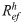
Estimation of Model TMAL in Period 1 (October/1995—September/2000).(a) observed incidence (O) and adjusted i (E), (b) m3/m, (c) Refh (h) and Refm (m), and (d) Ref=Refh×Refm.